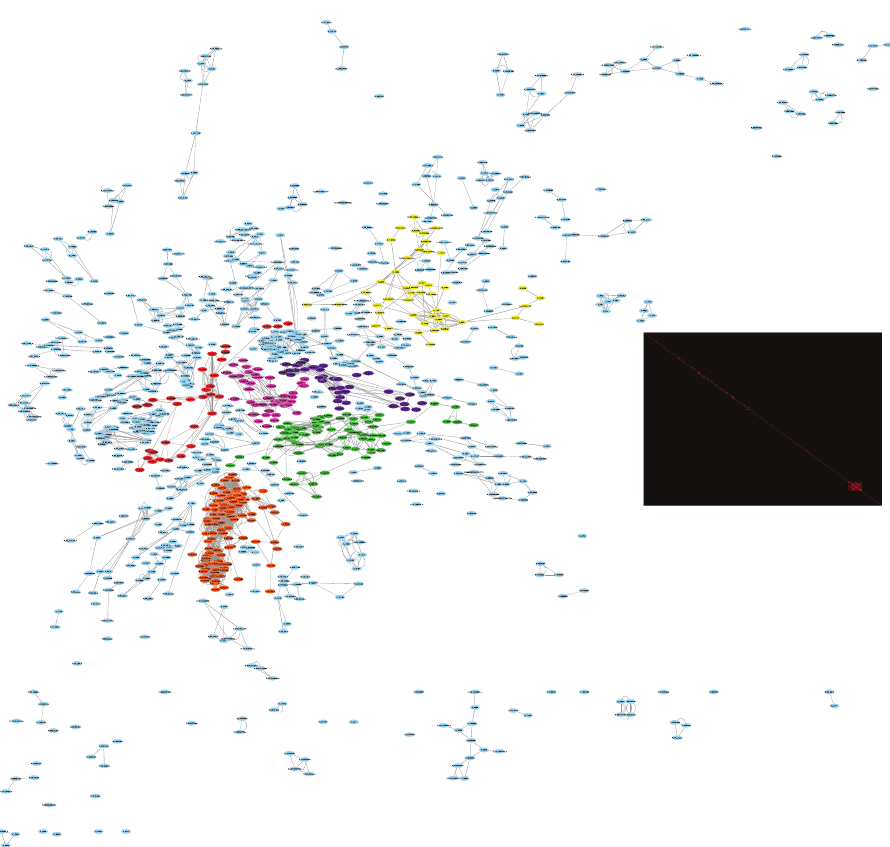
Fig 3. Modules of structural reversible reactions of Recon 2.2 model. The network was subdivided into modules of reversible reactions that share metabolites. Each node represents a reversible reaction and each edge a metabolite connecting two reversible reactions. The topology of the network is given by the invisible presence of irreversible reactions that connect the reversible reactions. The six largest modules that contain more than 30 reversible reactions: Glutamate metabolism, glutathione metabolism and TCA cycle (green), Fatty acids metabolism (yellow), Glycolysis, PPP, and galactose metabolism (red), Pyruvate, lactate, alanine and cysteine metabolism (purple), Glycine, serine and taurine metabolism (pink), and Nucleotides metabolism (orange). On the right the reaction adjacency matrix of the structural reversible reactions is presented, which also represents the reversible reaction